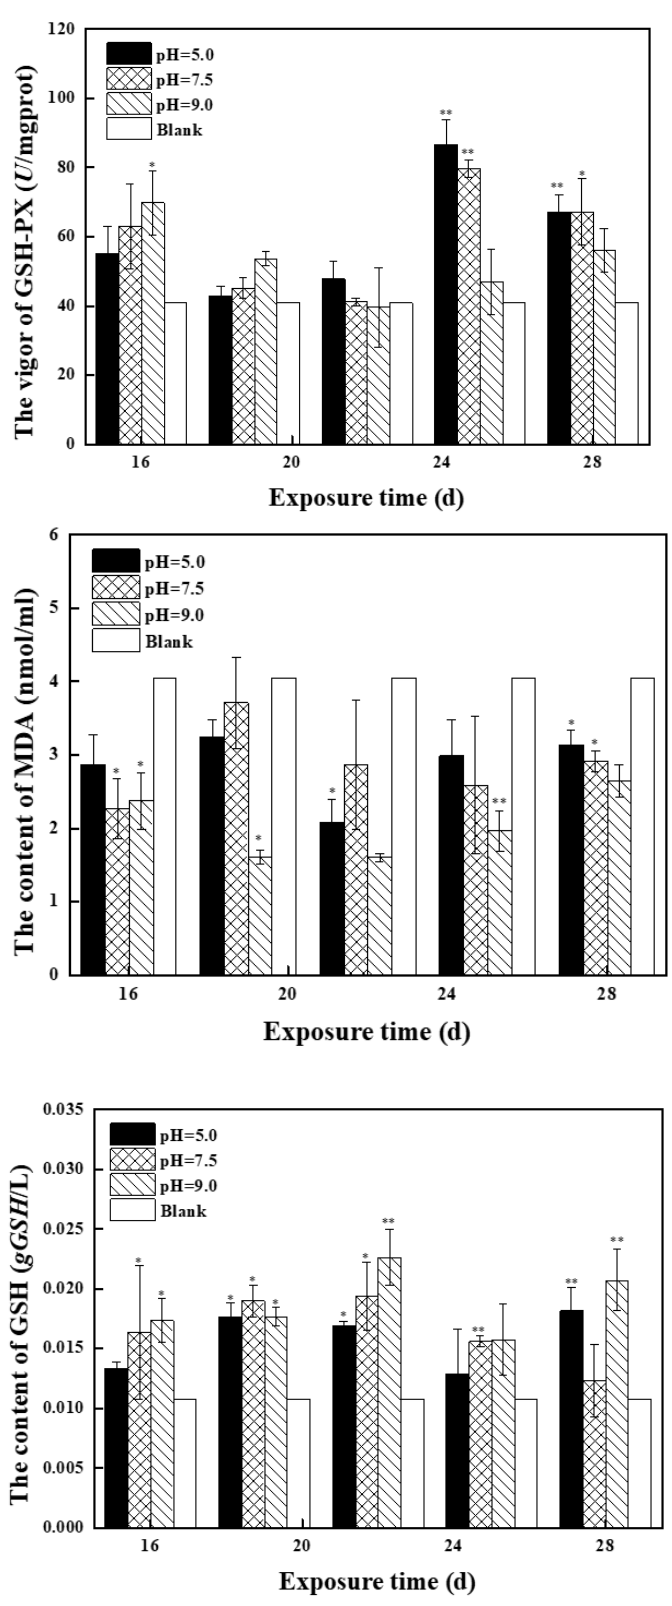
Figure 3. Effects of BPC and BPZ on antioxidant enzyme activity and MDA content in zebrafish ( n = 3) under different pH conditions (Note: 0.01 < * p < 0.05; ** p < 0.01, compared with the control group).